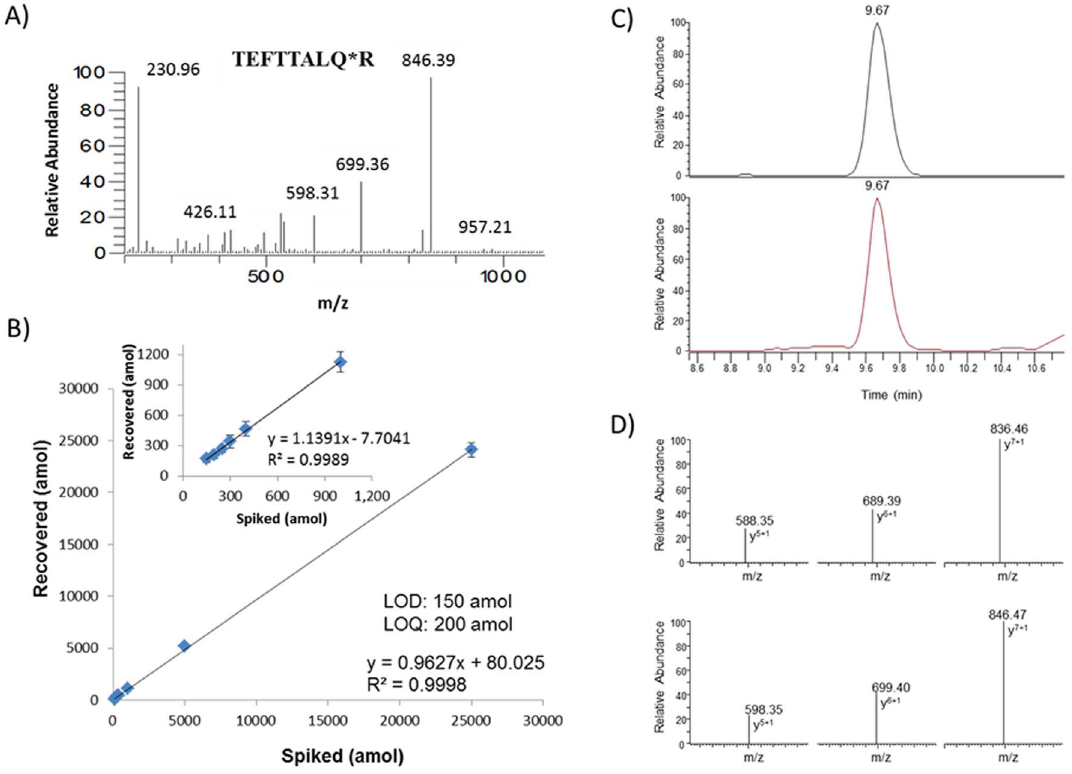
Figure 2. Development of SRM assay for Met showing the fragmentation spectrum for heavy TEFTTALQR peptide (A), the standard curve generated in human SK-BR-3 cell lysate (B); inset: the standard curve generated without the highest spiking point (25000 amol). The total ion chromatograms for the light and heavy isotopically labeled peptides are shown (C) along with the transition ions used to identify and quantitate each peptide (D).